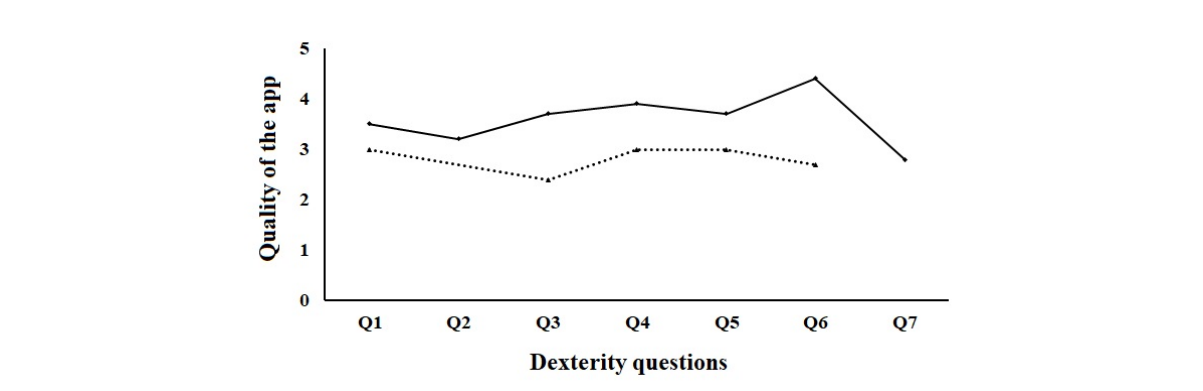
Figure 3. Quality ratings of the app regarding dexterity-related questions (Qs). The continuous line represents persons with multiple sclerosis. The dashed line represents healthy subjects. Scores range from 1 to 5: 1 = bad; 2 = moderate; 3 = good; 4 = very good; and 5 = excellent. Q1 = Were the exercises fun to play?; Q2 = Have you improved your fine motor skills?; Q3 = Was it easy to integrate the exercises into daily life?; Q4 = Were the explanations for the execution of each exercise sufficient?; Q5 = Would you recommend this application?; Q6 = Can you take the tablet well and easily on the go?; and Q7 = Do you notice improvements in everyday life regarding fine motor